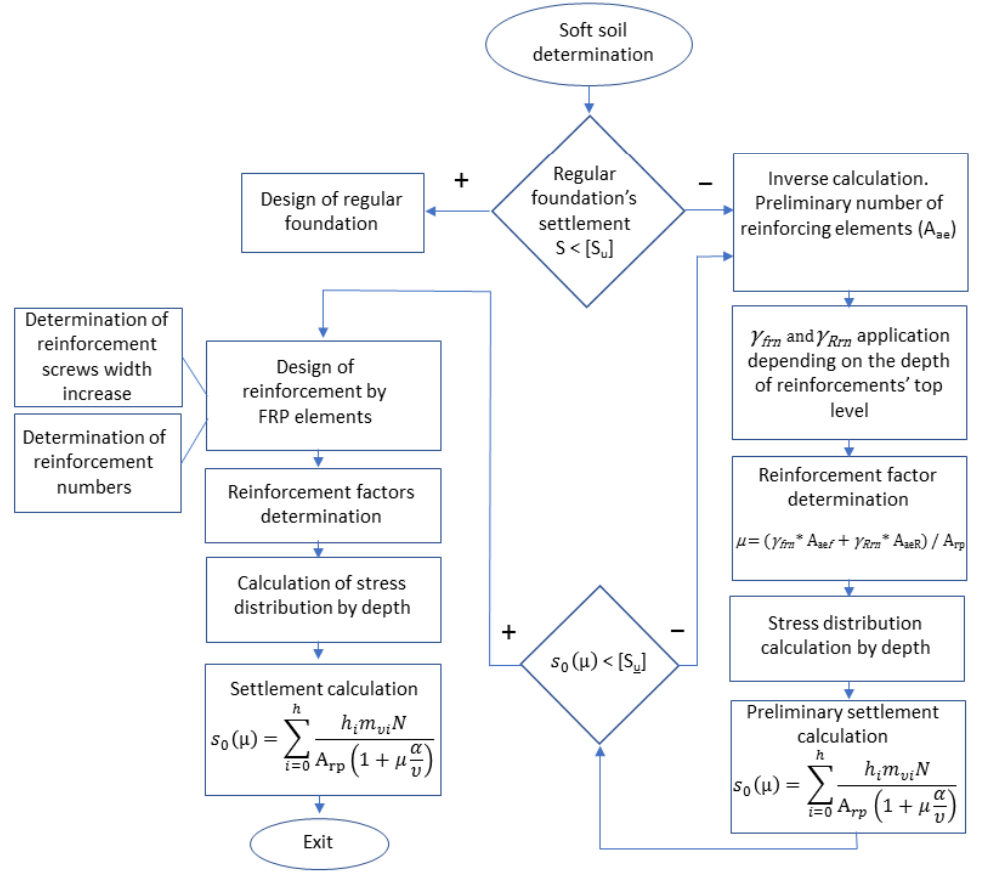
Figure 6. The proposed algorithm for modeling the soil massive reinforcement with FRP vertical